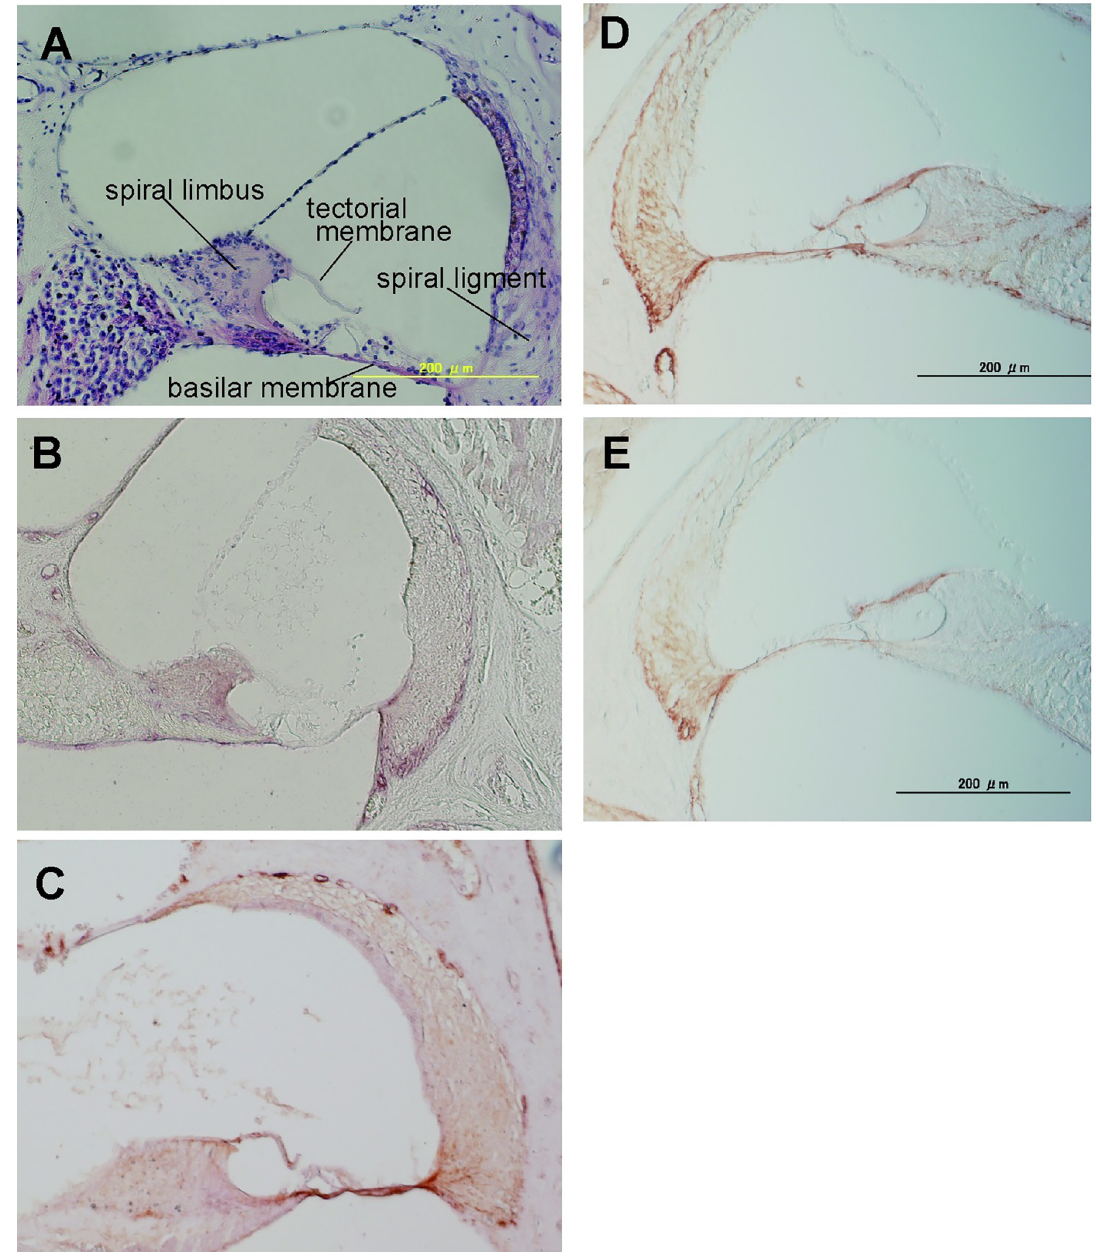
Fig 4. Histochemical staining of mouse inner cochlear tissue using mcochlin-Fc. Paraffin-embedded serial sections of C57BL/6 female mouse inner cochlear tissue was stained with (A) H&E, (B) anti-cochlin Ab, or (C) mcochlin-Fc. The same serial sections were stained with mcochlin-Fc without (D) or with heparinase treatment (E). Scale bar = 200 μ m. amino acid level, and the LCCL domains of these two proteins also show 94% homology each other. Comparing between mouse and human cochlins, five amino acid residues have signifi- cantly different properties (A31P, P51S, Y62F, S84G, T122A). Thus these amino acid residues may contribute to the different binding preference to the partially desulfated heparin. Since these point mutations are located in the LCCL domain, the results also indicated that cochlin